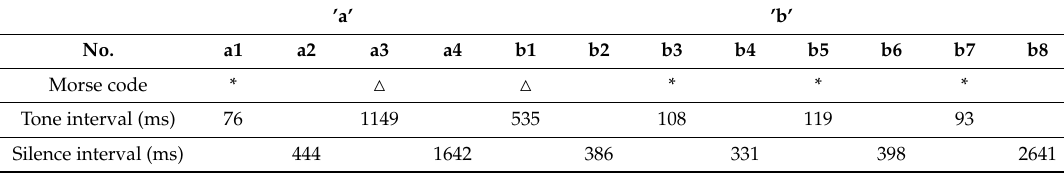
Figure 10. The intervals of corresponding Morse codes relating to ( a ) tone sequence of Morse code and ( b ) silence sequence of Morse code. (*: short tone, ∆ : long tone). Table 2. The input order and corresponding Morse codes of characters ’a’ and ’b’.